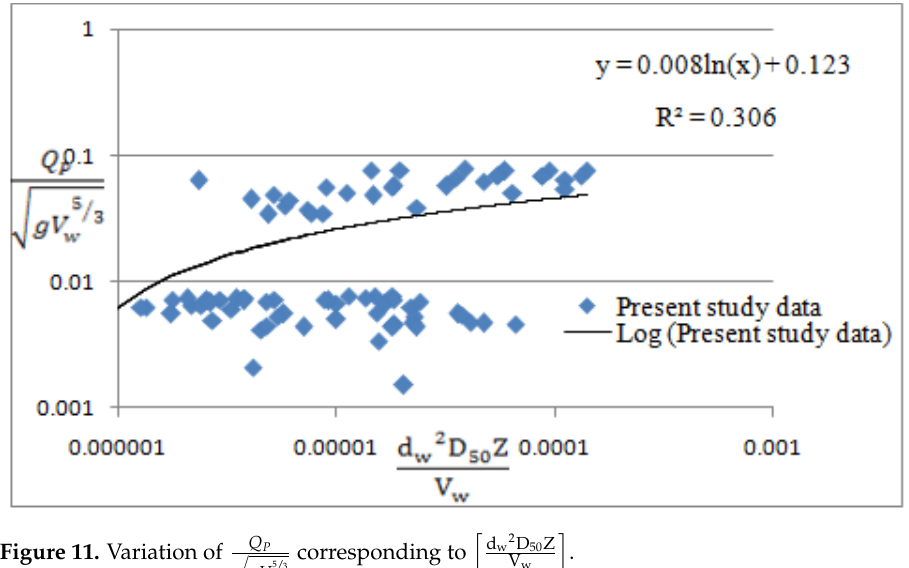
Figure 11. Variation